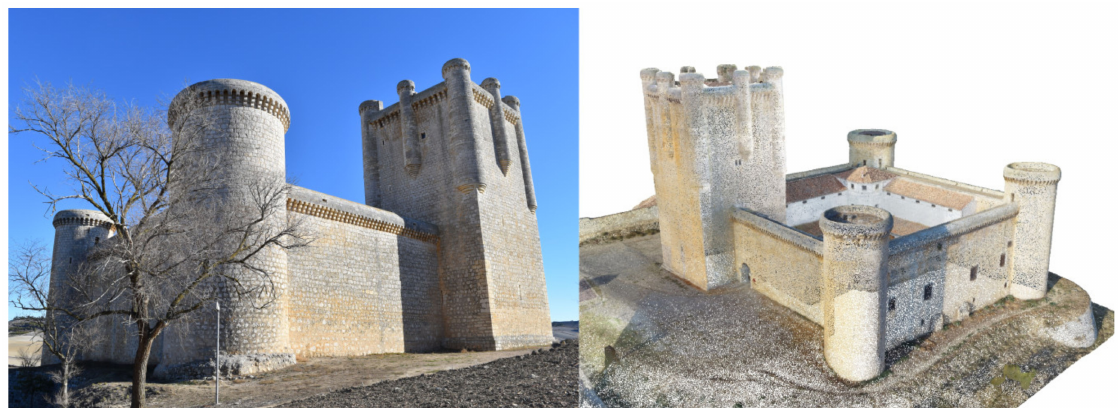
Figure 1. Complete point cloud of the Castle of Torrelobat ó n into REVIT as